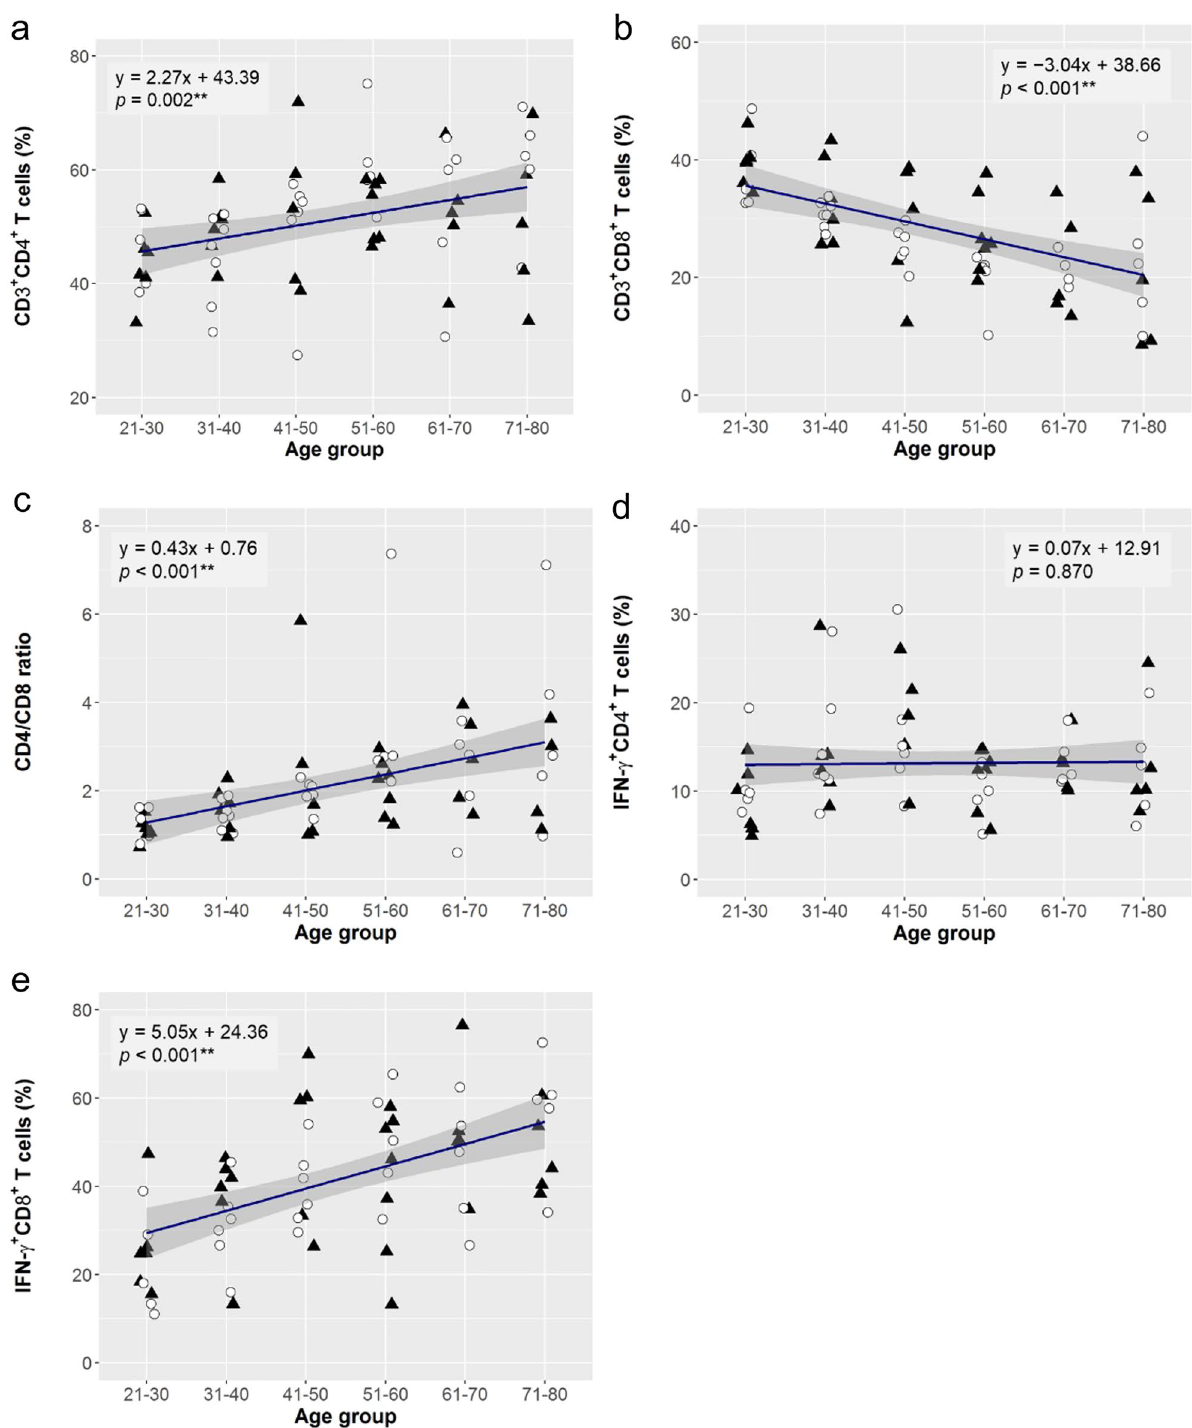
Figure 2. Age-associated changes in T cell subsets. Linear regression analysis to evaluate effect of aging on the frequencies of CD4 + T cells ( a ; CD3 + CD4 + T cells), CD8 + T cells ( b ; CD3 + CD8 + T cells), IFN-γ + CD4 + T cells ( d ) and IFN-γ + CD8 + T cells ( e ), and CD4/CD8 ratio ( c ). The linear regression curve is plotted for the data of 67 subjects (33 females: open circle, 34 males: closed triangle), and its equation and p -value (** p < 0.010) for the effect size of ageing are shown. The statistics of the analysis are summarised in Table